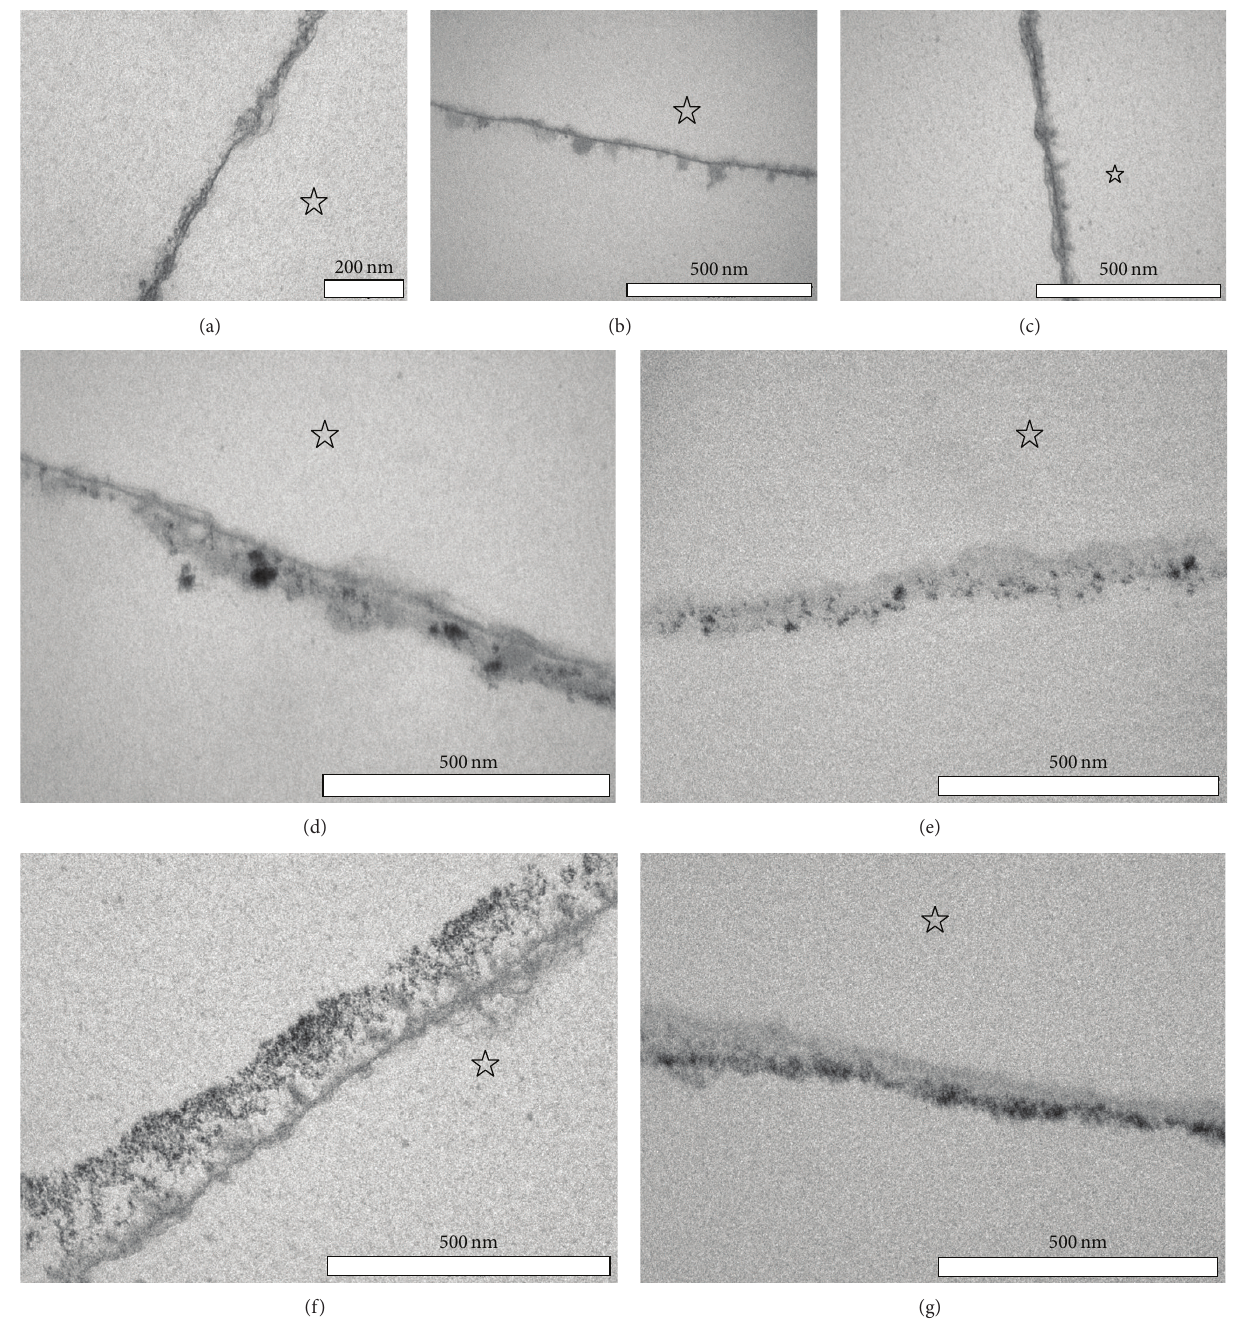
Figure 5: Transmission electron microscopic images of the in situ formed 30 min pellicle without pretreatment (a) and with pretreatment with Biorepair mouth rinsing solution (b, d, e) and GC Tooth Mousse (c, f, g) at 98.000-fold magnification. For representative images of the influence of elmex Kariesschutz on in situ pellicle formation previously published by our workgroup see Weber et al. [33]. The enamel was removed during the preparation of the samples; the former enamel site is marked with an asterisk. After 30 min of physiological pellicle formation a fine electron-dense basal layer (basal pellicle) as well as a thin fine granular second layer can be detected at the enamel surface (a). Clearly neither rinses with Biorepair mouth rinsing solution ((b, d) contrasted, (e) uncontrasted) nor the application of GC Tooth Mousse ((d, f) both contrasted, (g) uncontrasted) after 1min of pellicle formation seemed to affect or penetrate the characteristic appearance of the basal layer. However, in 10% of the analyzed pellicle, ultrastructural changes that are possibly due to an accumulation of electron-dense mineral componentscouldbevisualizedintheouterpartsofthe in situ formedpellicle28 minafterpretreatmentwiththeprophylacticproducts(d–g). While the inorganic electron-dense aggregates after rinsing with Biorepair mouth rinsing solution appear randomly distributed throughout the pellicle layer (d, e), electron-dense inorganic particles are more homogenously arranged and densely attached to the outer parts of the in situ formed pellicle after application of the Tooth Mousse paste (f,